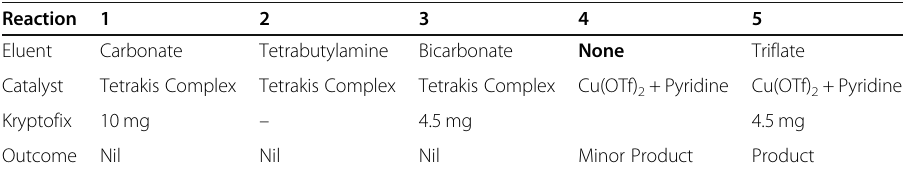
Table 3 Trialled reaction conditions for model systems Reaction